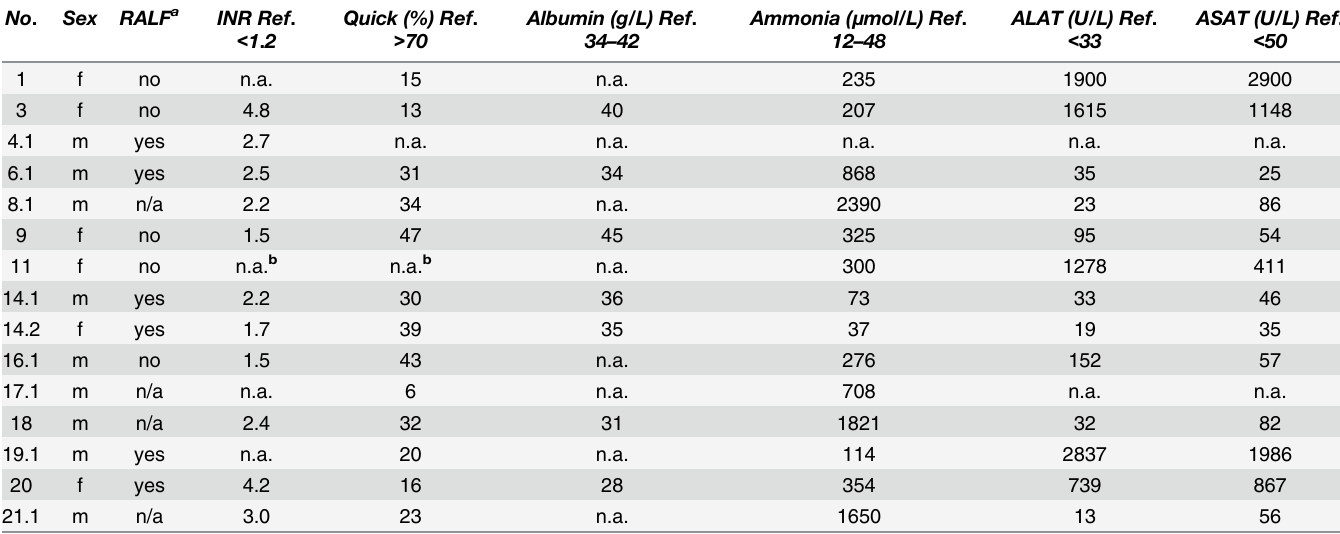
Table 2. Laboratory values of OTCD patients suffering from acute liver failure. INR Ref . < 1 . 2